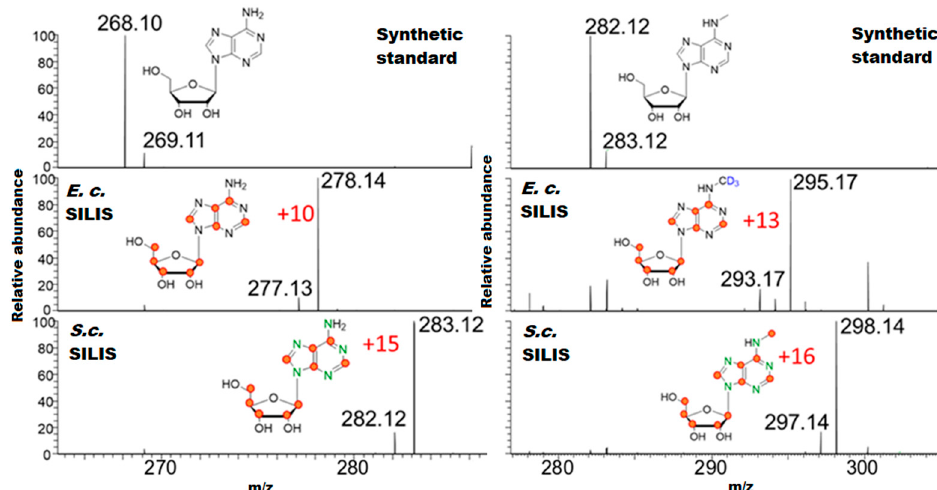
Figure 2. The mass spectra of adenosine ( left ) and 6-methyladenosine (m 6 A, ( right )) are shown for the synthetic standard, the E. coli stable isotope-labeled internal standard ( E. c. SILIS) and S. cerevisiae SILIS ( S. c. SILIS). Atoms that were stable isotope labeled are indicated in red for carbon-13, blue for deuterium and green for nitrogen-15.